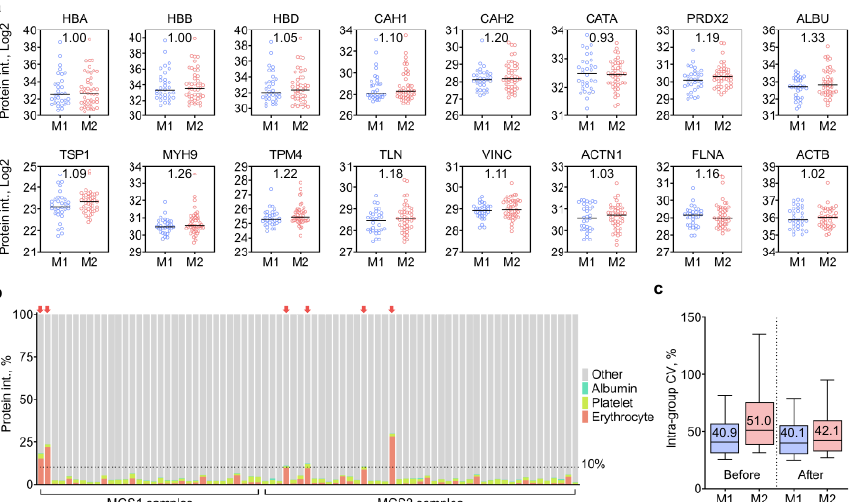
Figure 3. RPE sample qualification by evaluating blood protein contamination. ( a ) Protein MS intensities of the 16 selected blood proteins (7 erythrocyte-specific proteins, 8 platelet-specific proteins, 1 serum albumin) in MGS1 (M1) and MGS2 (M2) samples; ( b ) percentage of blood proteins (protein MS intensities) in individual samples; arrows indicate samples above the 10% threshold; ( c ) intra- group CV levels for MGS1 and MGS2 groups before and after removal of outlier samples.